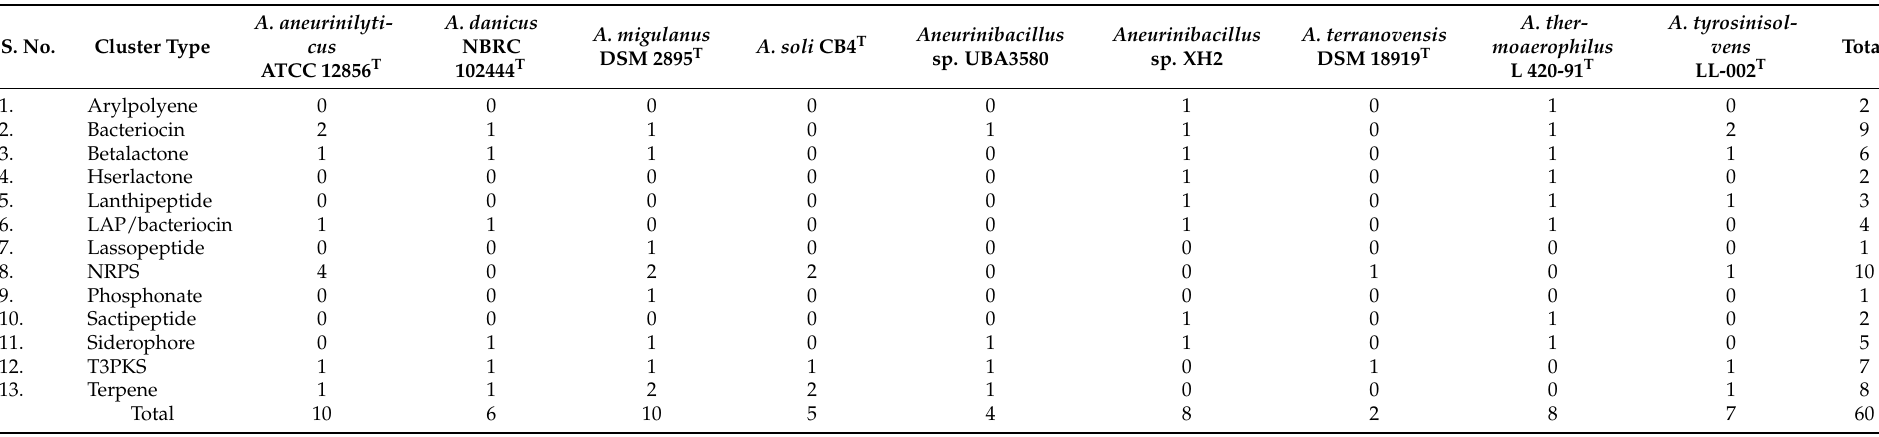
Table 3. Distribution of different types of biosynthetic gene clusters in the genomes of various Aneurinibacillus